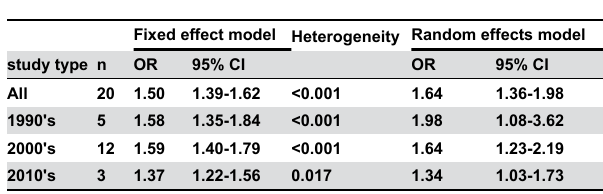
Table 3. Pooled Odds Ratio for prostate cancer and prostatitis by decades.